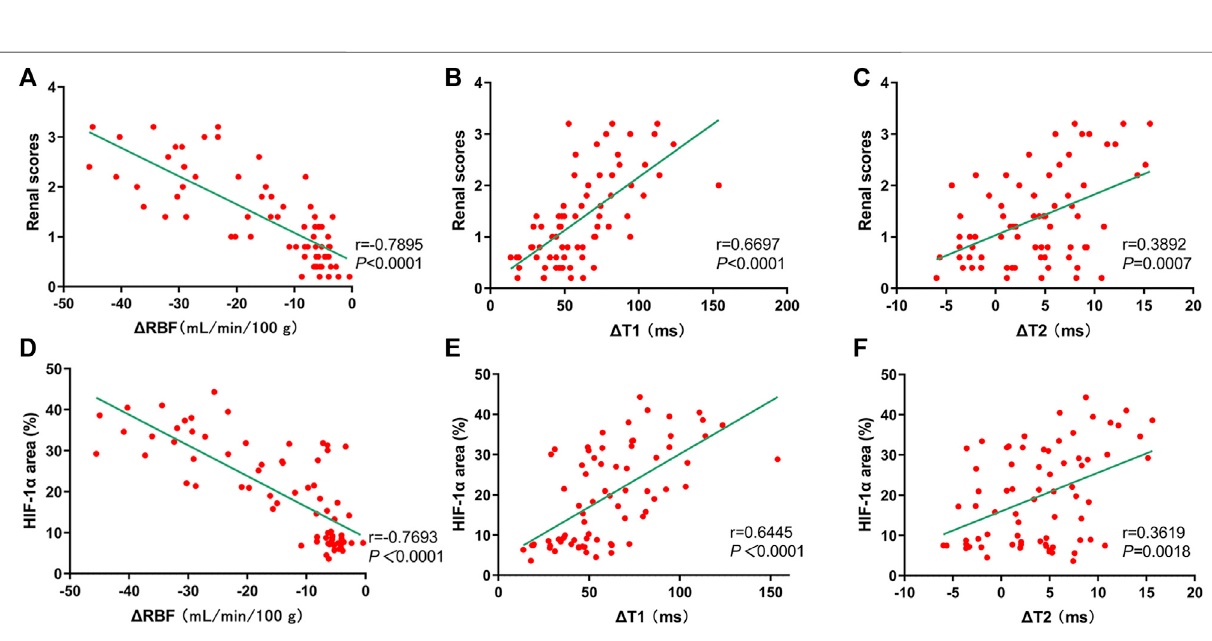
Frontiers in Pharmacology |